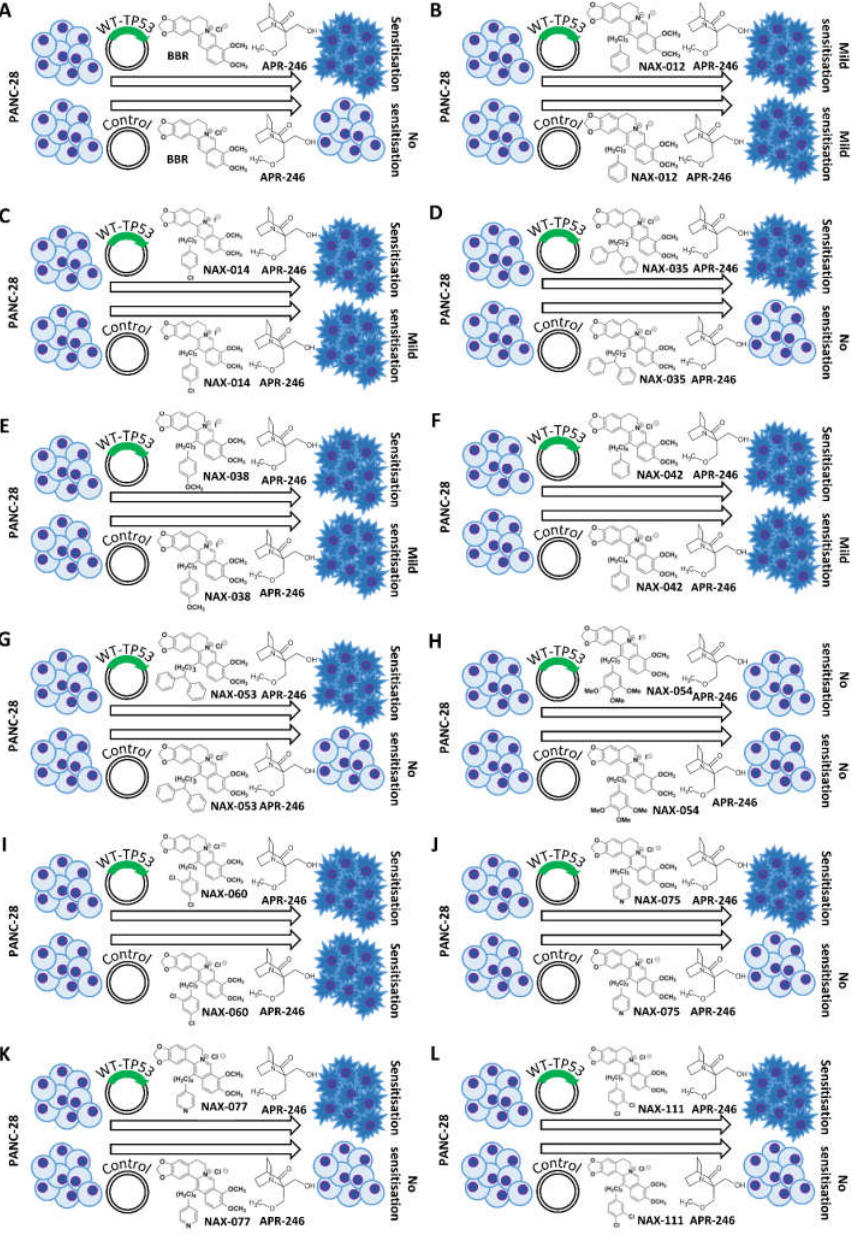
Figure 18. Chemical structures of BBR and NAX compounds and the potential effects of the mutant TP53 reactivator APR-246 to increase their toxicity of PANC-28 + pLXSN and PANC-28 + WT-TP53 cells. Abilities of APR-246 to interact with BBR and NAX compounds and cause increased growth inhibition in PANC-28 cells either in the presence of non-expressed (TP53 null) or the same cells with introduced WT-TP53. ( A ) = Berberine, ( B ) = NAX012, ( C ) = NAX014, ( D ) = NAX035, ( E ) = NAX038, ( F ) = NAX042, ( G ) = NAX053, ( H ) = NAX054, ( I ) = NAX060, ( J ) = NAX075, ( K ) = NAX077, ( L ) =